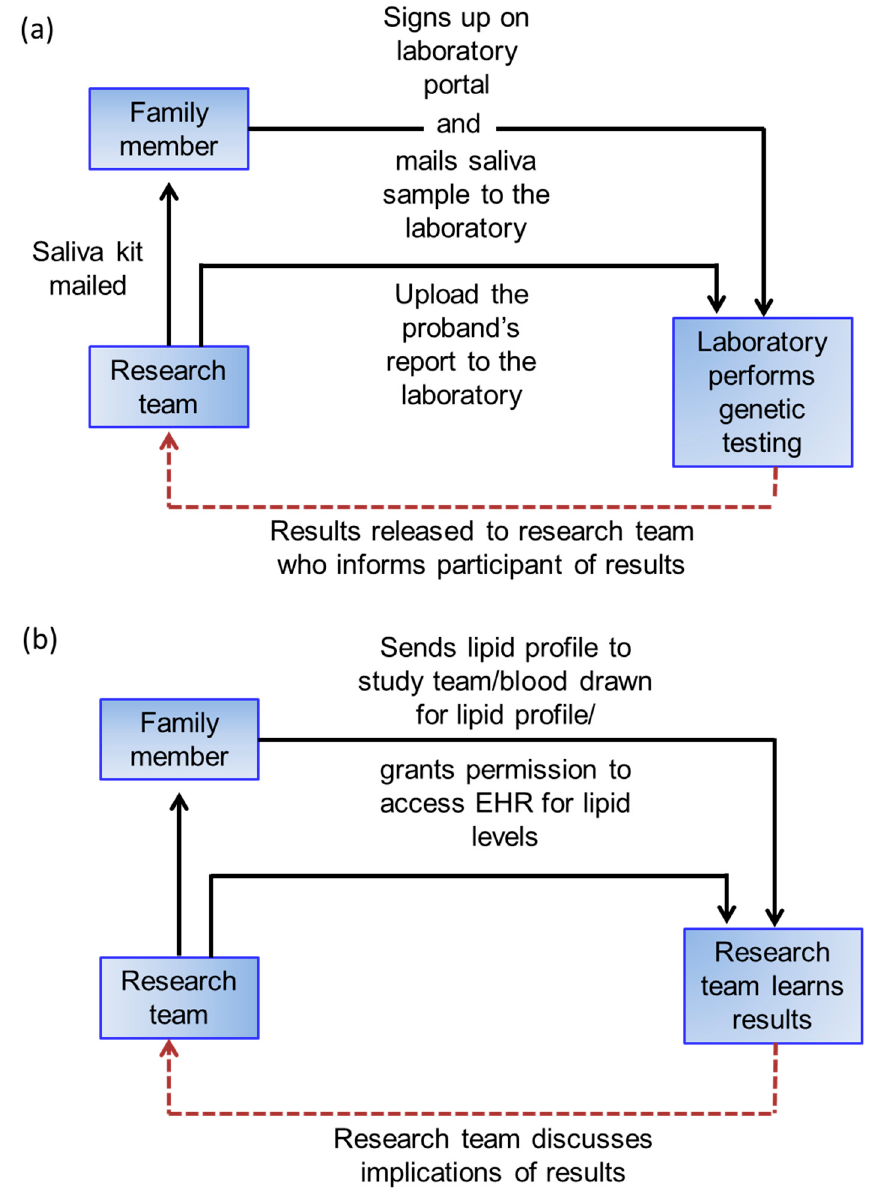
Figure 3. Approach for testing family members of patients with ( a ) definite FH; ( b ) probable/possible FH. EHR: electronic health record.